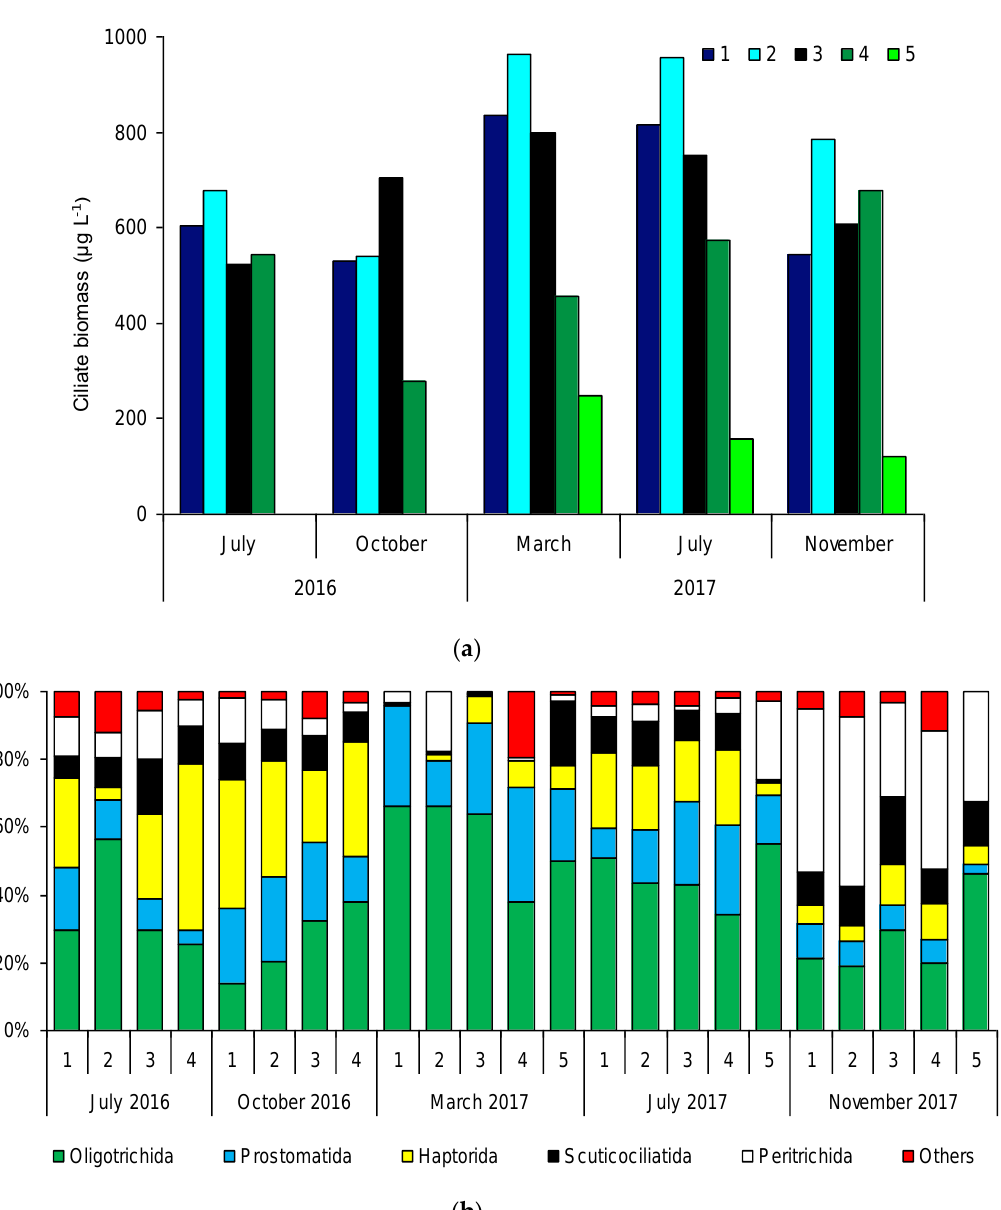
Figure 5. Temporal and spatial distribution of ciliate biomass ( a ) and composition ( b ); sites 1–4 in Lake Warnołty, site 5 in Lake Śniardwy.